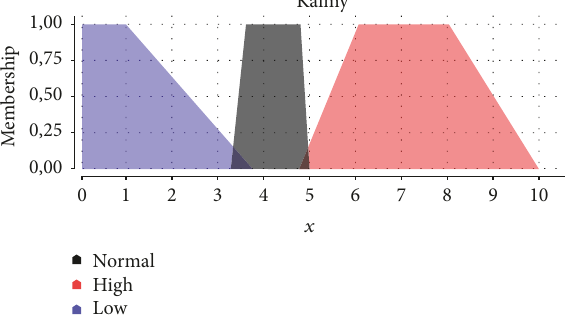
Figure 4: The range of Kalmy